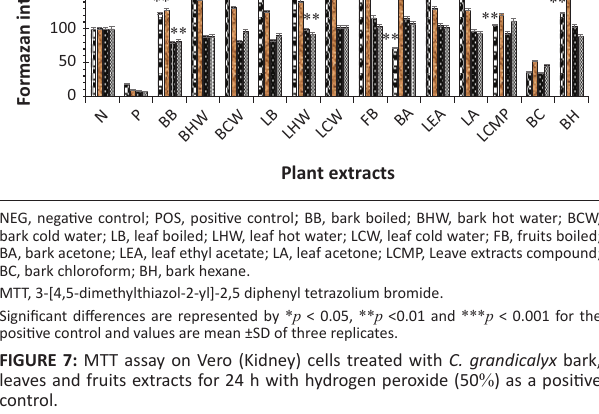
FIGURE 7: MTT assay on Vero (Kidney) cells treated with C. grandicalyx bark, leaves and fruits extracts for 24 h with hydrogen peroxide (50 % ) as a positive